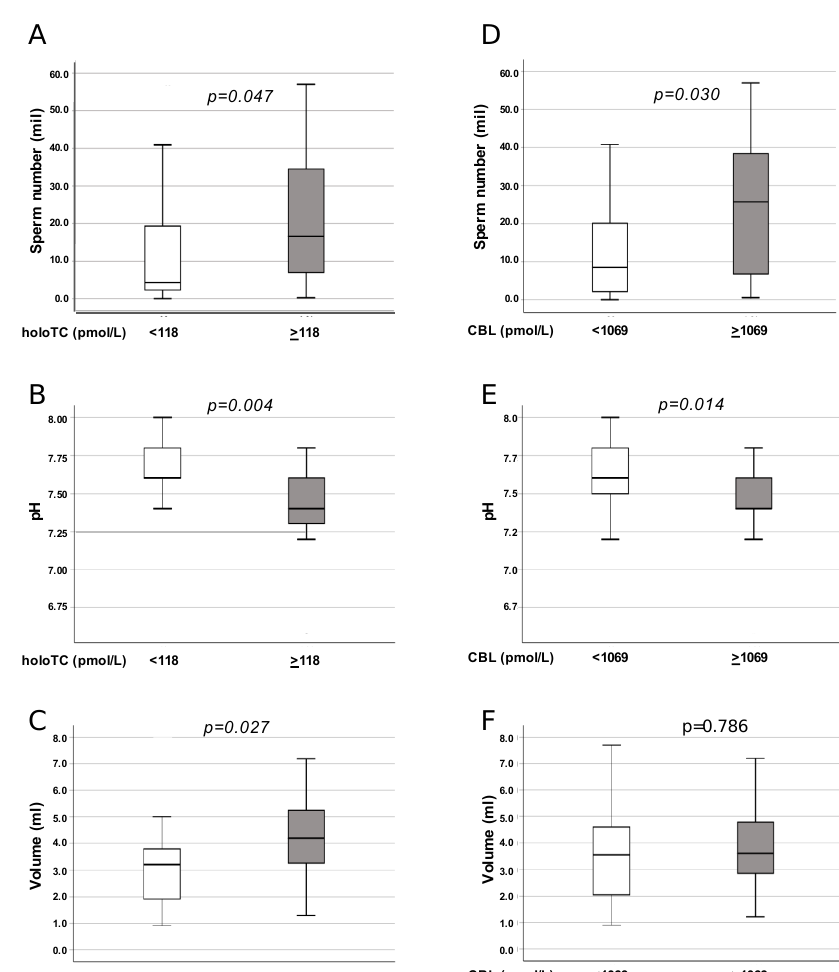
Figure 3. Seminal parameters stratified for seminal holoTC and CBL in the total population of obese and lean subjects. Data reported as box charts indicates sperm number ( A,B ), seminal pH ( C,D ), and volume ( E,F ) in all subjects stratified for low and high seminal holoTC ( A,C,E ) and CBL ( B,D,F ), respectively. Cut-o ff values were chosen as the median value of holoTC (118 pmol / L) and CBL (1,069 pmol / L) distribution in the whole population; p values were calculated with the Mann-Whitney U In both cohorts, CBL and holoTC concentrations were significantly higher in semen vs. serum 209 samples (CBL: P<0.001, and holoTC: P<0.005, Table 2, Fig.2). Morbidly obese subjects presented 210 significantly lower concentrations of both CBL (p=0.006) and holoTC (p=0.025) in semen compared 211 to lean subjects (Tab.1, Fig.2), while the differences between the two cohorts reached a statistical 212 significance in the serum for CBL only (p=0.012, Table 1, Fig.2). Not-statistically significant 213 correlations were found between holoTC/CBL and BMI, weight, waist circumference (WC), sex 214